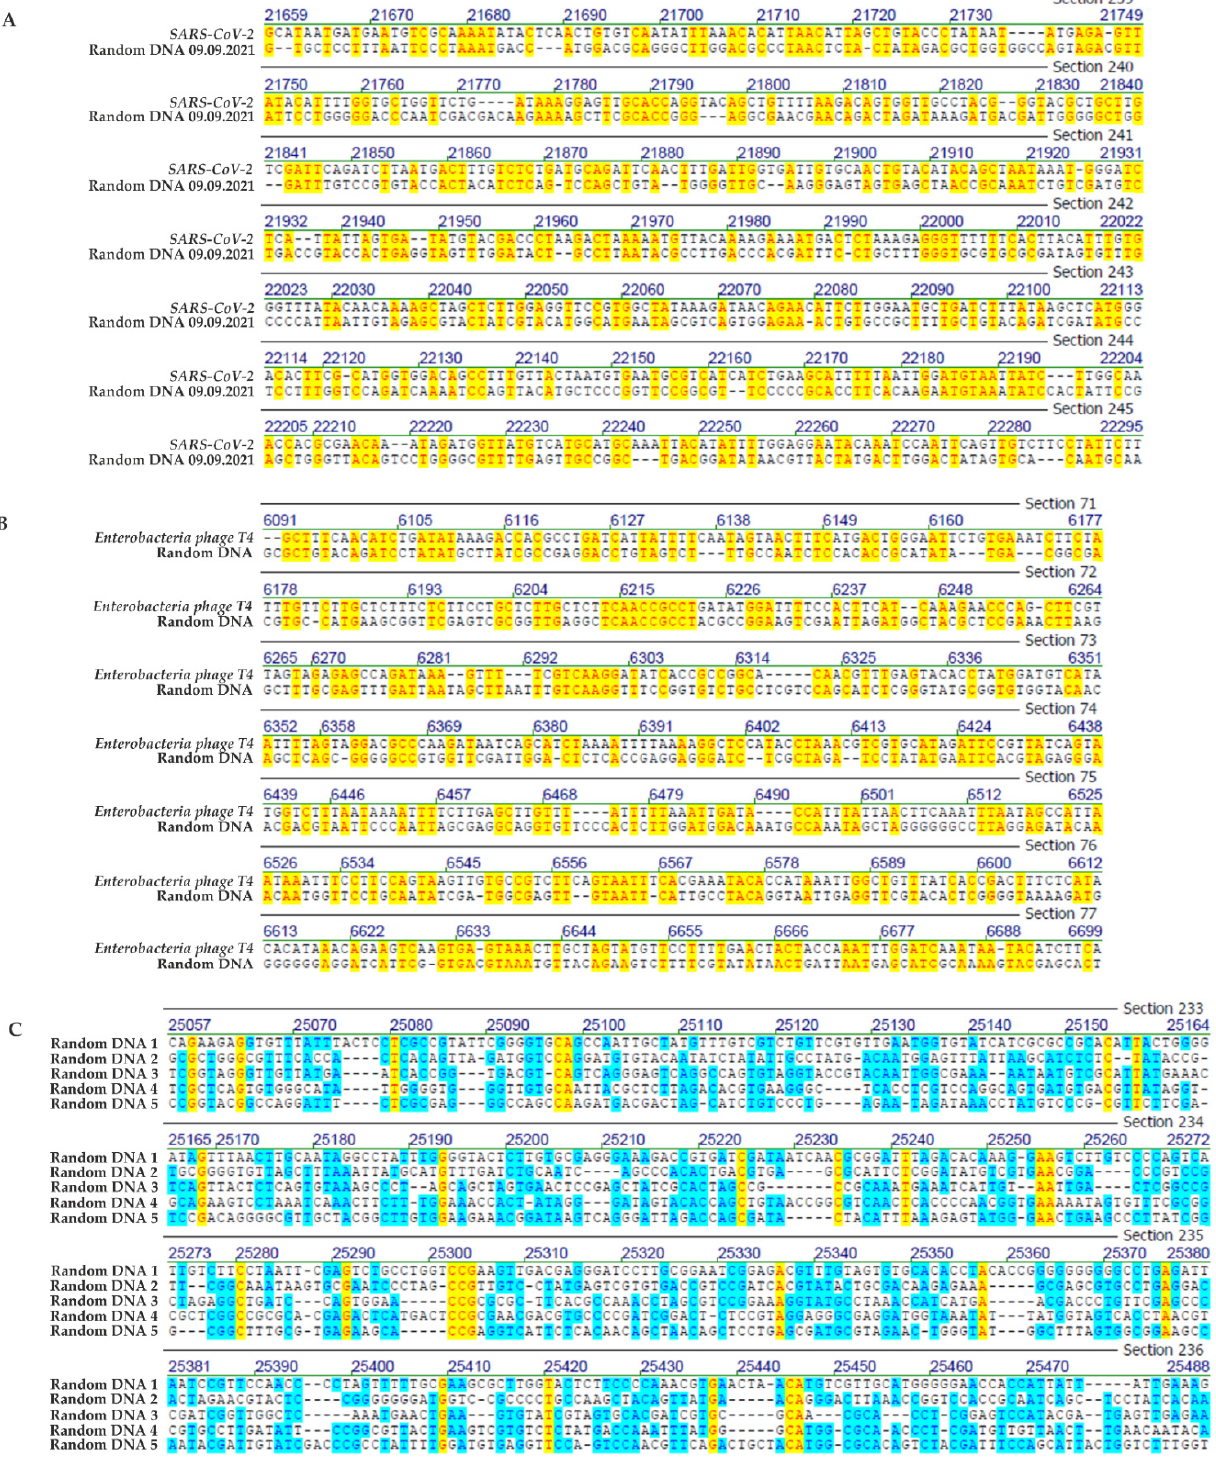
Figure 7. ( A ) Sequence alignment between Wuhan SARS-CoV-2 and a randomly computer-generated DNA. ( B ) Sequence alignment between bacteriophage T4 and a randomly computer-generated DNA. ( C ) Sequence alignments between five randomly computer-generated DNAs. The different highlights have been explained in the legends of Figures 1–4. The blue highlights in part ( C ) indicate sequence identities among different randomized sequences.